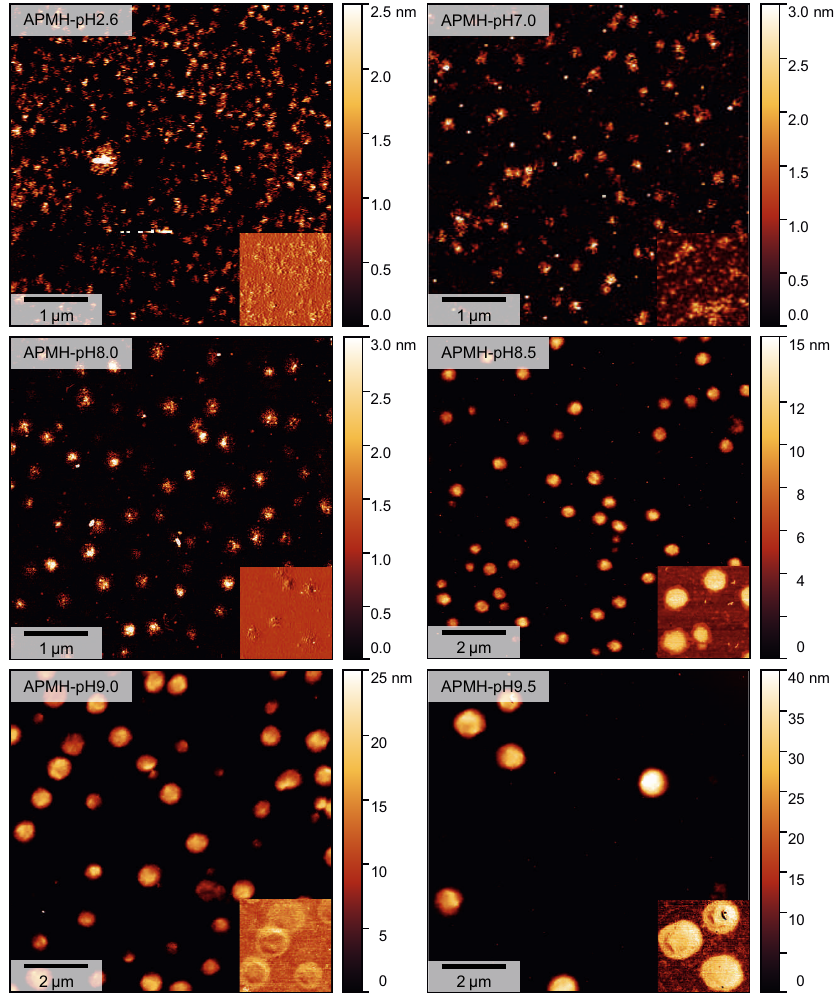
Figure 9. AFM images (topography) of the obtained poly(NIPAM- co -APMH) microgels, synthesized at different reaction pH. The insets show representative cutouts of the respective phase-image (same lateral scale). The samples were measured in the dried state at room